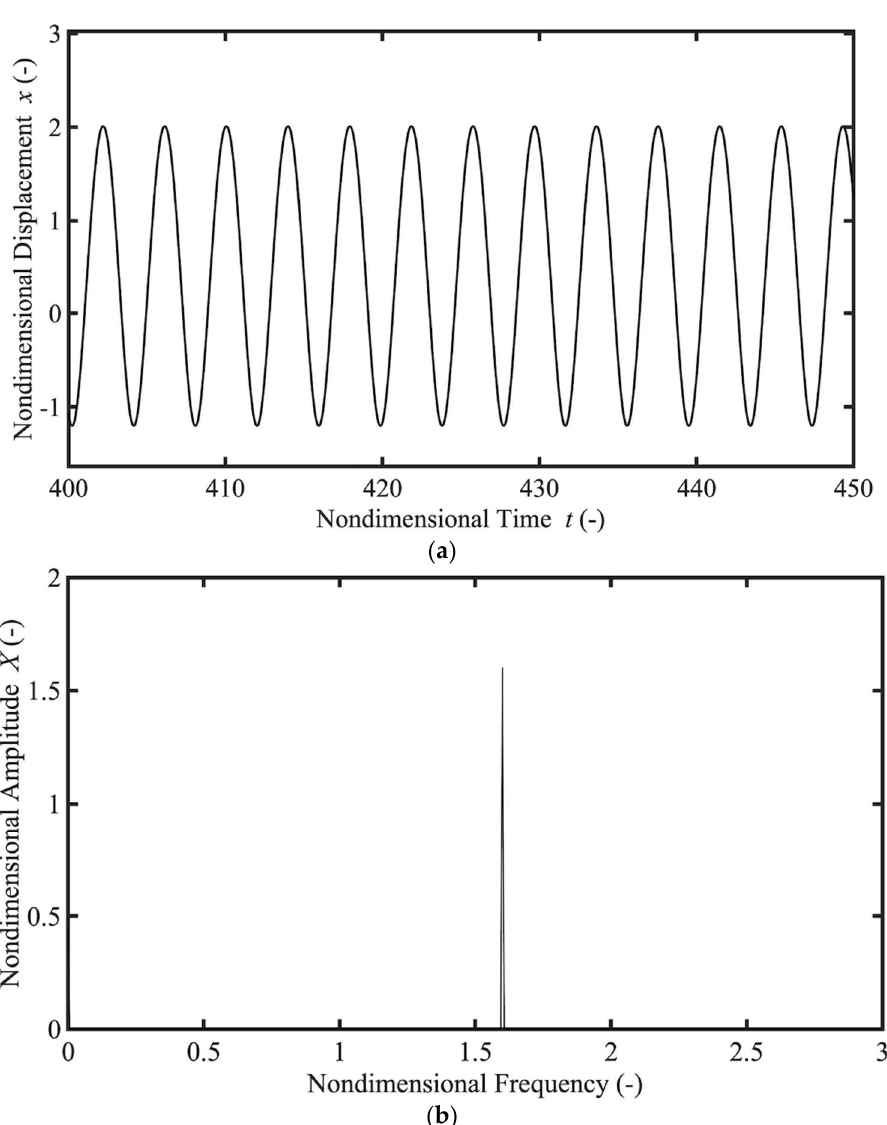
Figure 8. Numerical results of the motion of the magnet above the superconductor excited with the amplitude A = 1.0 mm and frequency ν = 1.6 using the parallel-type shunt damper, showing no subharmonic resonance. ( a ) Time history; ( b ) FFT.